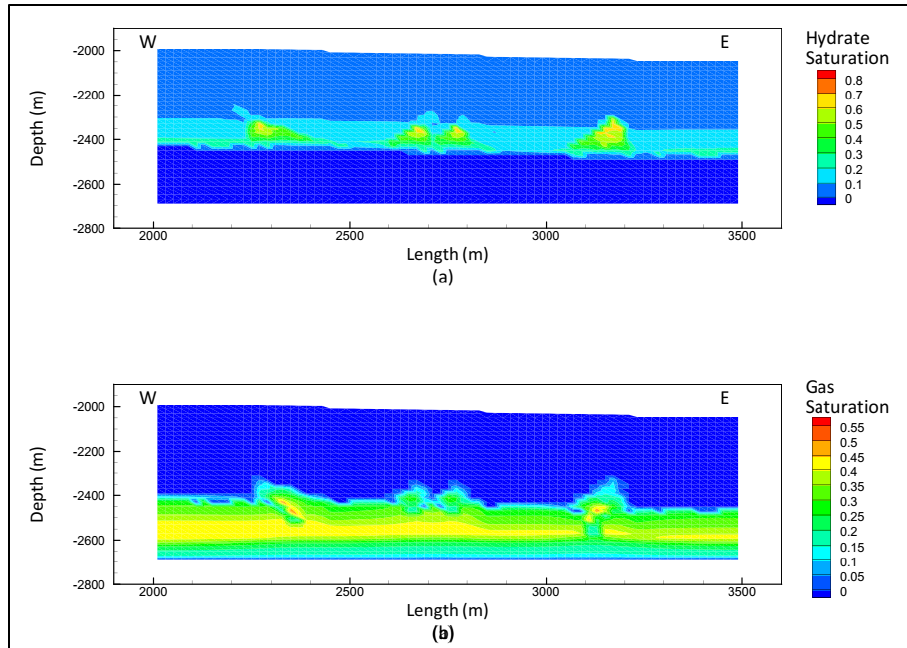
Figure 6. ( a ) Hydrate saturation after 100 years of steady warming by 1 °C. The hydrate mass decreases by 0.1%, and the maximum saturation is 72%. ( b ) The total mass and sediment volume of the gas layer increased as hydrates started dissociating along the base of the stability zone.